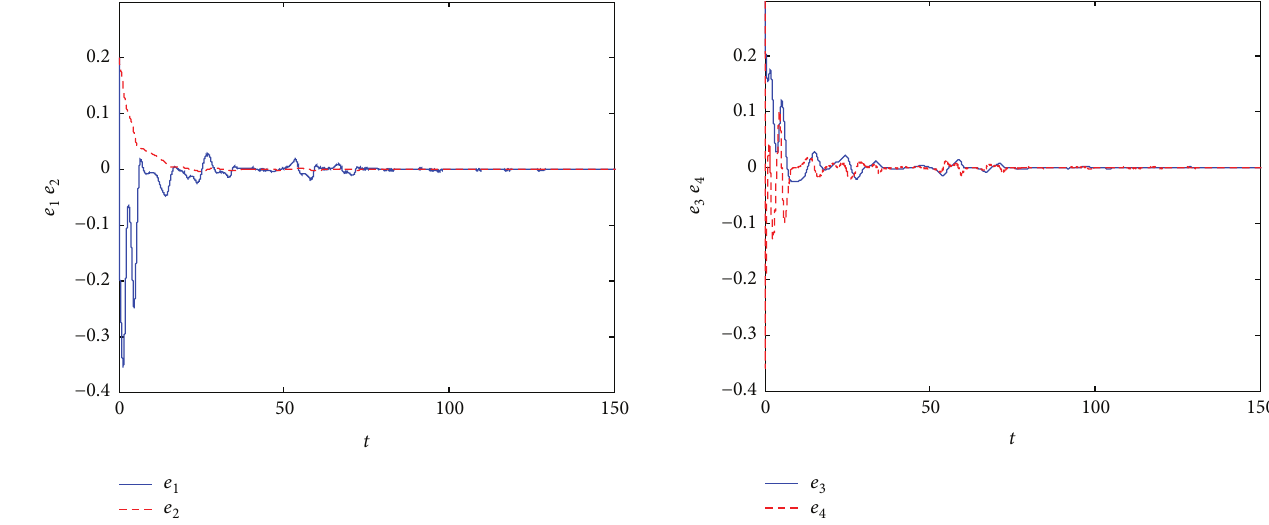
Figure 3: Error signals between the pair of Van der Pol system. Figure 4: Error signals between the pair of Duffing